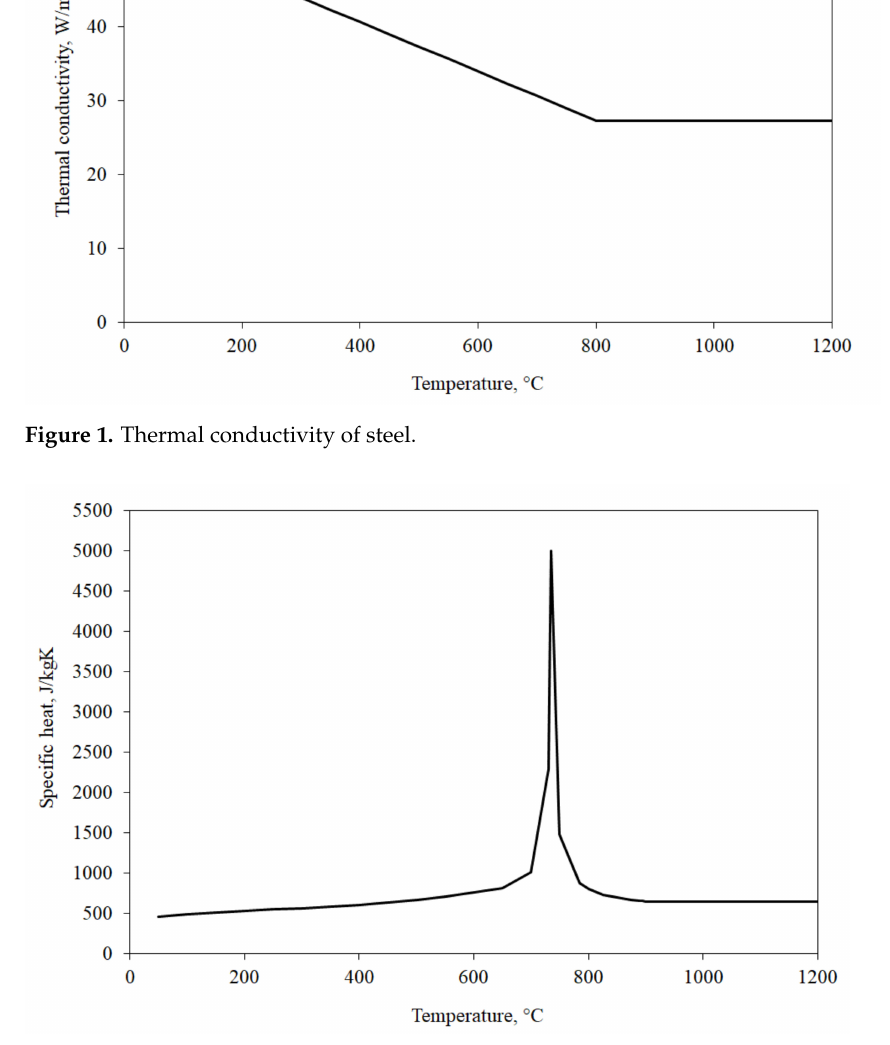
Figure 2. Specific heat capacity of